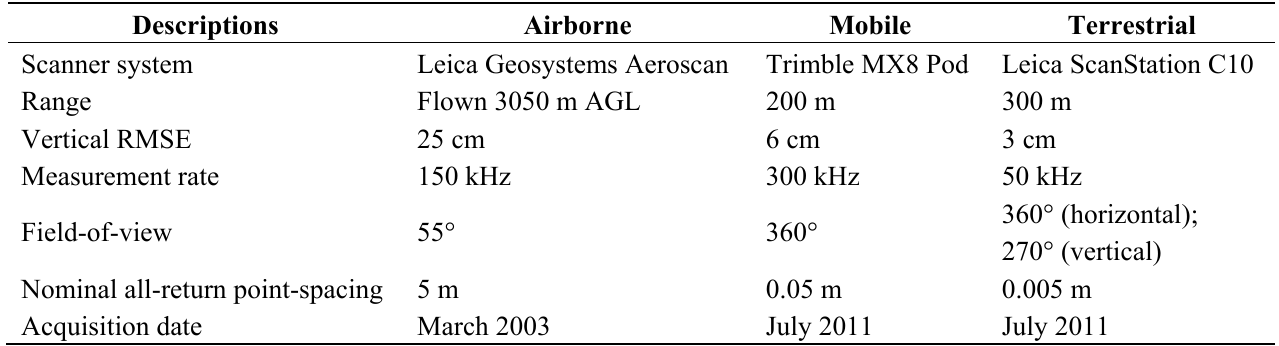
Table 1. Comparative table of the applied LiDAR sensors and data